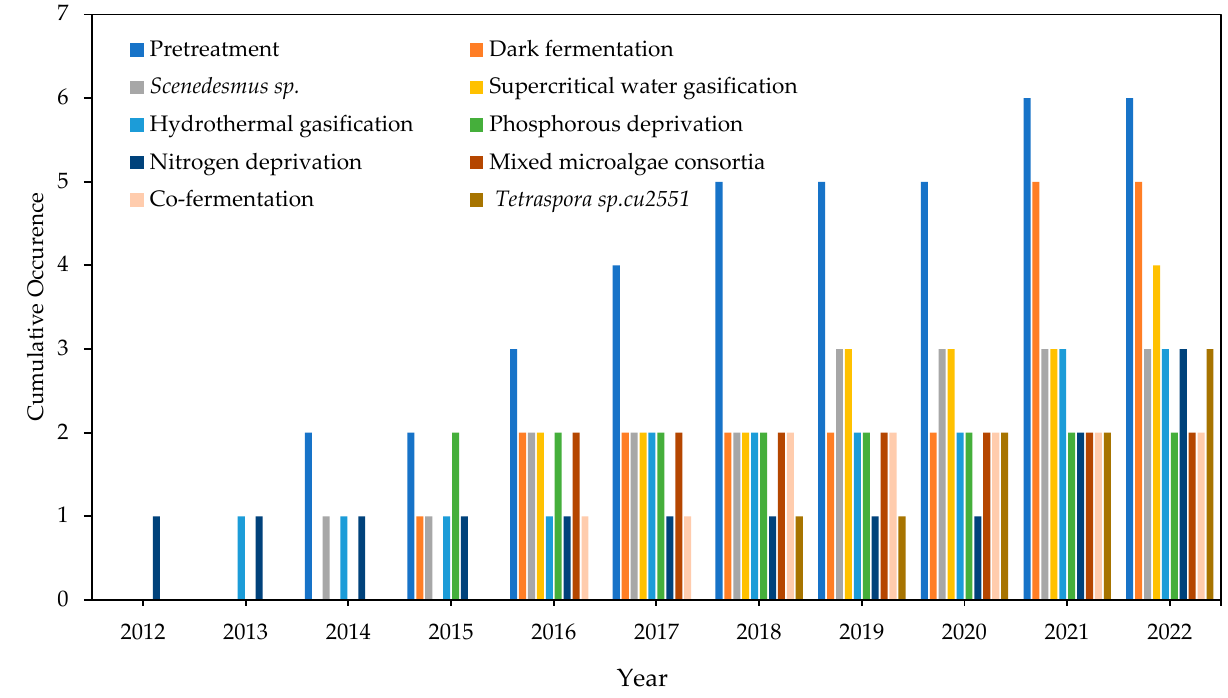
Figure 5. Emerging keywords in the field of biohydrogen production using microalgae.